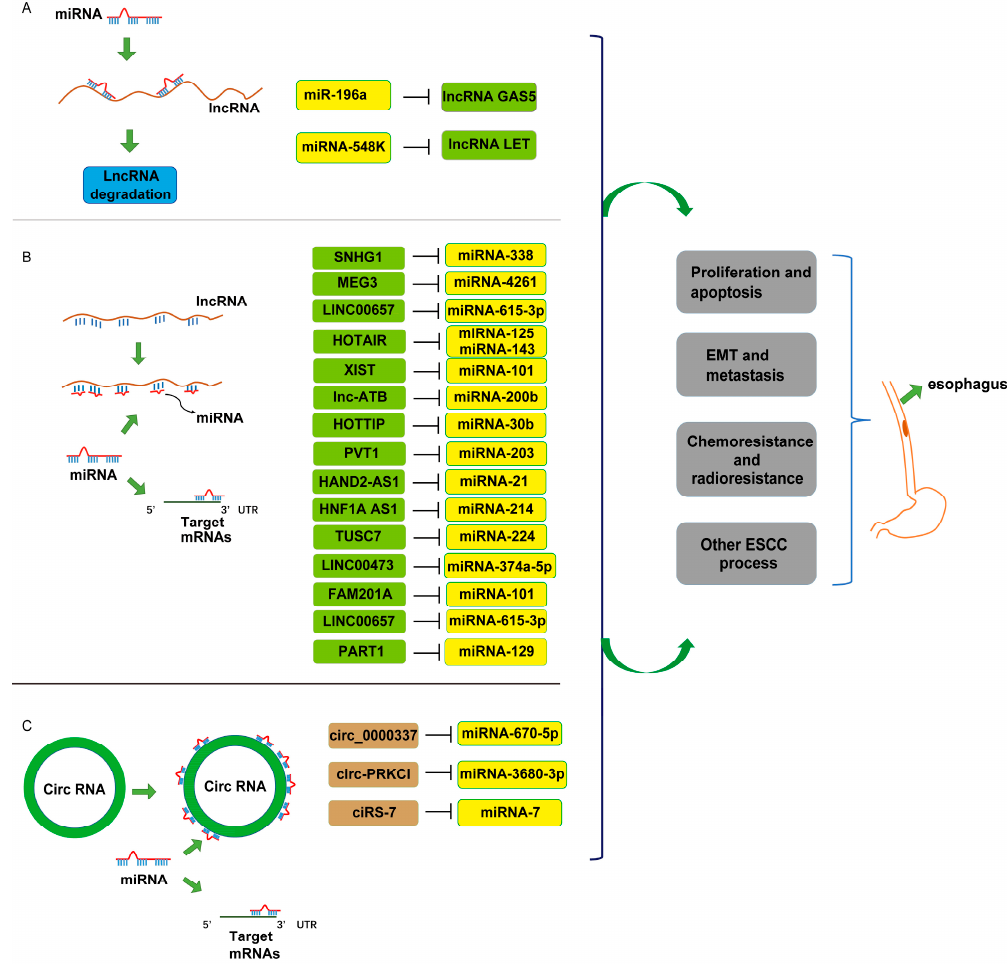
Figure 1. Non-coding RNA (NcRNA) regulatory interaction in esophageal squamous cell